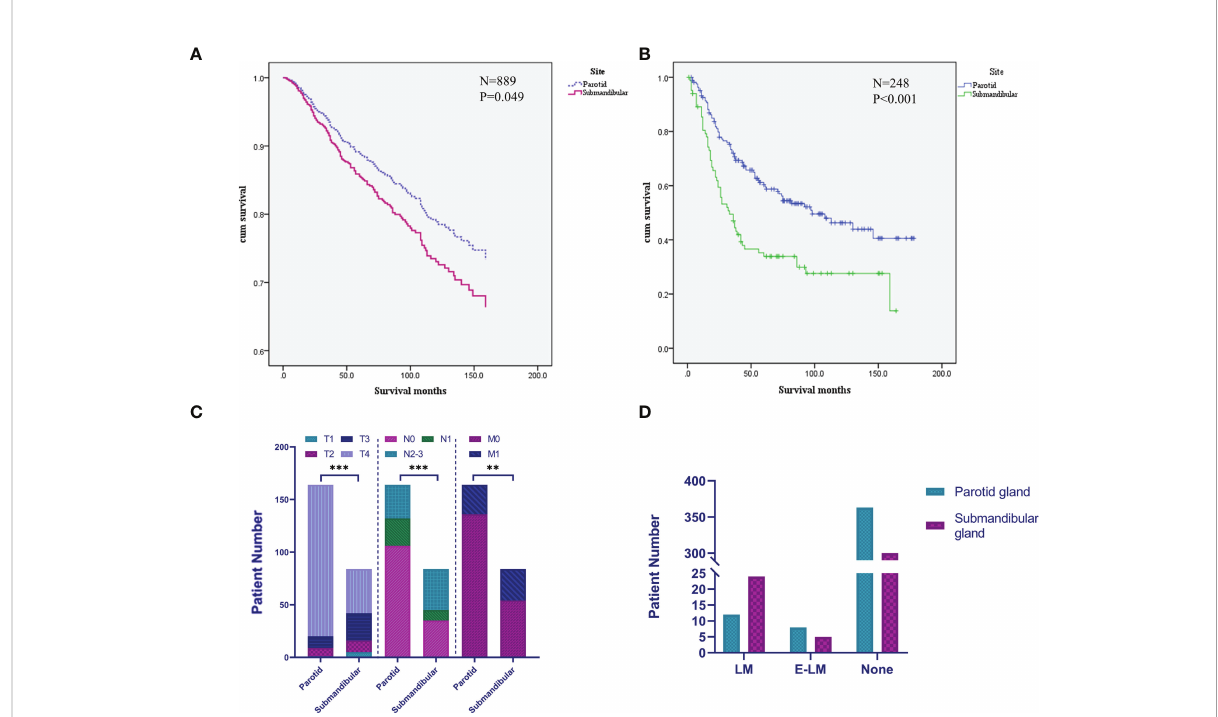
FIGURE 4 Differences in the prognosis and clinical characteristics of patients with submandibular/parotid gland ACC in the SEER database. (A) Survival curves for patients with submandibular and parotid glands ACC analysed using the Cox regression model. (B) Survival curves for patients with stage IV submandibular and parotid glands ACC analysed using the Kaplan-Meier method. (C) Difference in the distribution of TNM staging in patients with stage IV submandibular and parotid glands ACC. (D) Distribution of distant metastases of submandibular and parotid glands ACC. LM, lung metastasis; E-LM, extrapulmonary metastasis; None, no distant metastasis found (** P-value <0.01; *** P-value